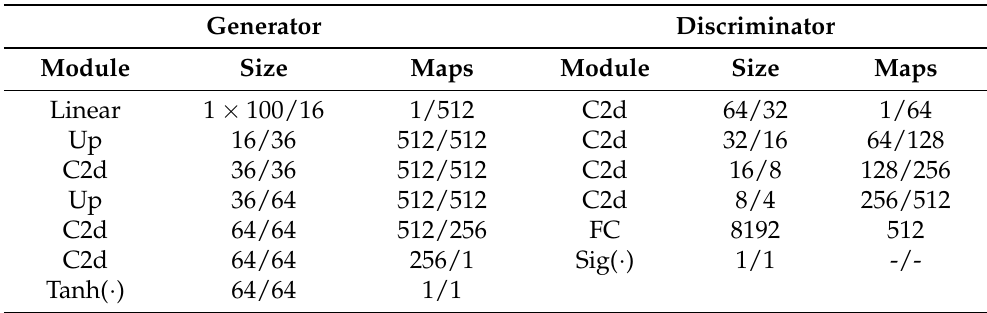
Table 2. GAN Network Architecture: The input to the GAN generator (a) is a latent vector of length 100 multiplied which is processed through multiple convolutional (C2d) and upsampling (Up) layers. The output of the generator is a hyperbolic tangent (Tanh). The output of the discriminator (b) goes to a fully connected (FC) layer followed by a sigmoid function (Sig).